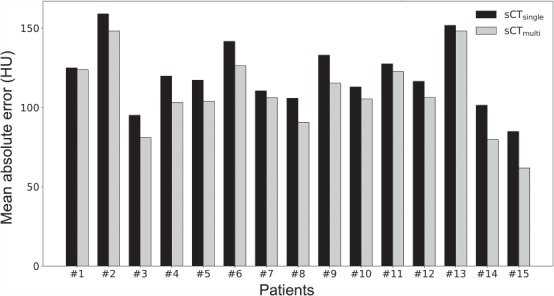
A comparison of MAE within the body contour between sCTsingle and sCTmulti of all 15 patients.